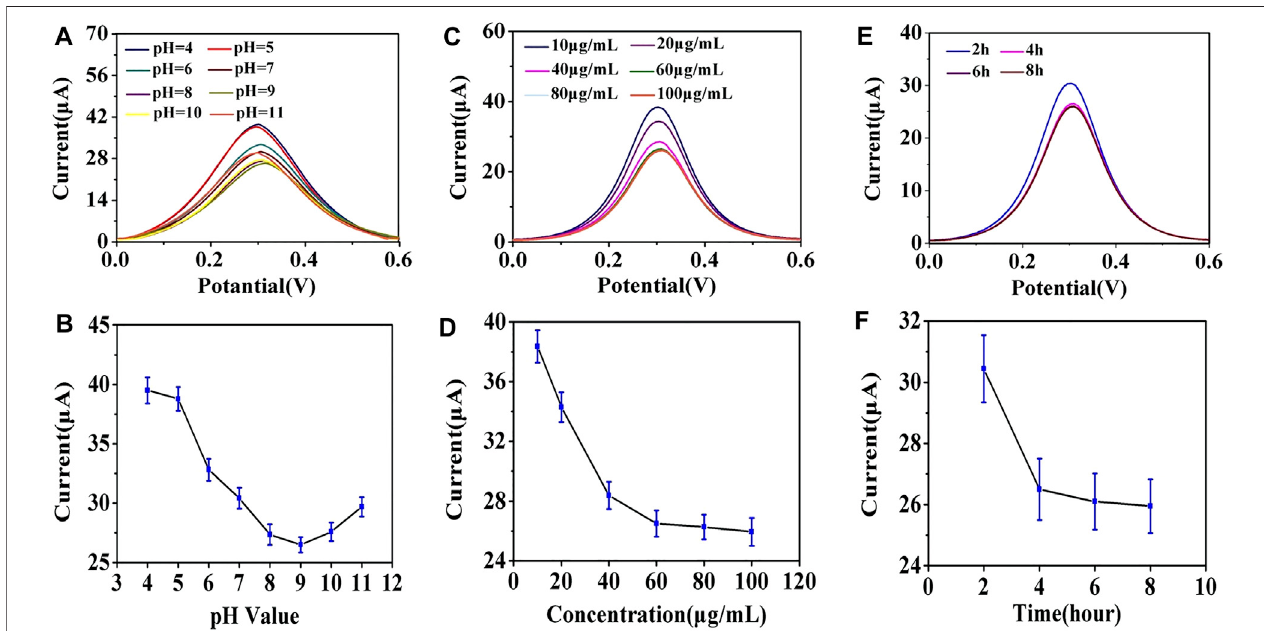
FIGURE4|(A) Effectofanti-EpCAM-modi fi edpHvalueonDPVresponse. (B) linegraphoftheeffectofthepHvalueonthepeakcurrentvalueofDPV. (C) effectof anti-EpCAMconcentrationonDPVresponse. (D) linegraphoftheeffectofanti-EpCAMconcentrationonthepeakcurrentvalueofDPV. (E) effectofanti-EpCAMbinding time on the DPV response. (F) line graph of the effect of anti-EpCAM binding time on the peak current value of